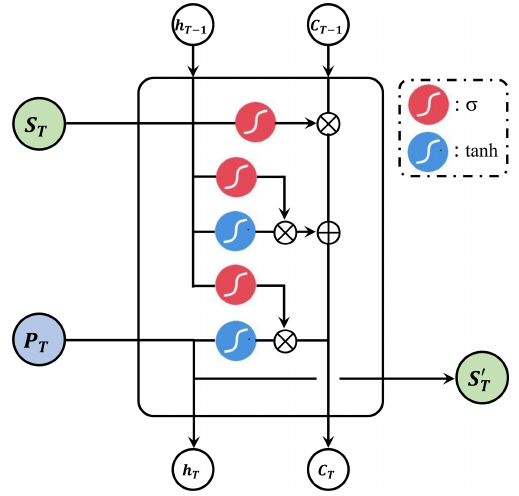
Figure 5. Structure of the LSTM model in the proposed